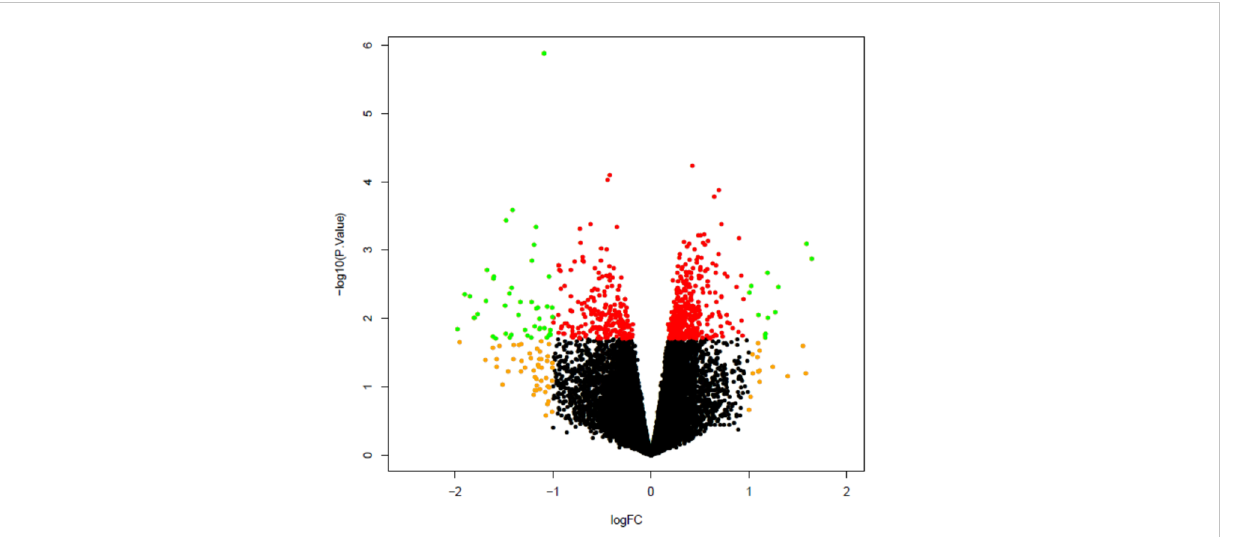
FIGURE 8 Volcano plot comparing plaque macrophage gene expression in infected mice as compared to mock infected mice. All microarray probes, both coding and non-coding, are represented. Volcano plot compares log2 (fold change) to log10 p value. Green dots represent differentially expressed